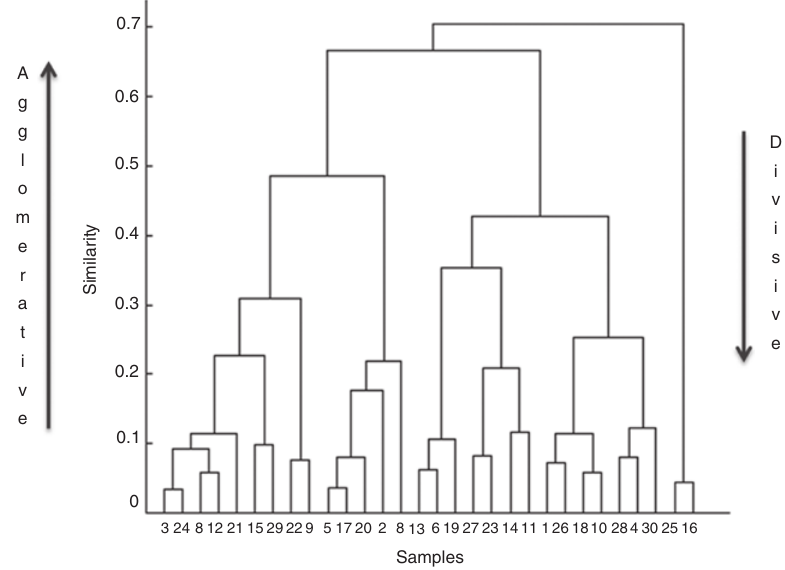
Figure 3: Representation of a dendrogram acquired by